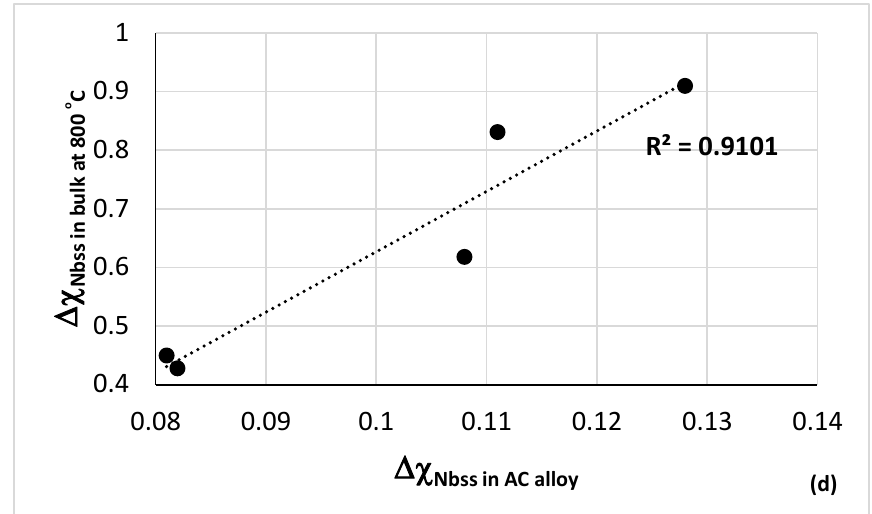
Figure 10. ( a ) δ Nbss versus ∆ χ Nbss ( b ) δ Nbss versus VEC Nbss , ( c ) VEC Nbss versus ∆ χ Nbss and ( d ) ∆ χ of contaminated Nb ss in the bulk of alloy after isothermal oxidation at 800 ◦ C versus ∆ χ of “uncon- taminated” Nb ss in AC alloy. ( a – c ) colours: brown for Nb ss in AC alloy, green for Ti rich Nb ss in AC alloy, blue for Nb ss in diffusion zone (DZ) formed at 800 ◦ C, red for Nb ss in bulk of alloy isothermally oxidised at 800 °C. Diamonds for CC/HE Nb ss . In each part the R 2 value is for the linear fit of all the data. Data for the alloys NV1, NV2, NV5, ZX5 and ZX7. See Appendix A for nominal alloy compo- sitions and references.